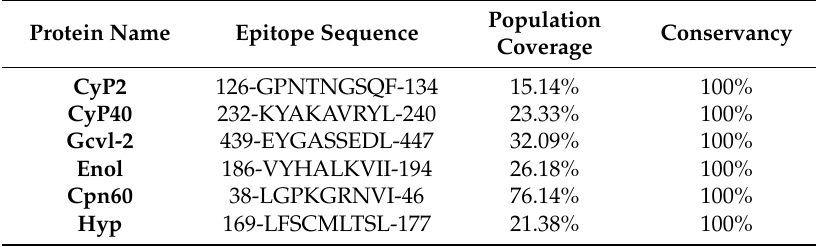
Table 1. Selected cytotoxic T lymphocyte (CTL) epitopes among L . infantum proteins to be a part of the multi-epitope